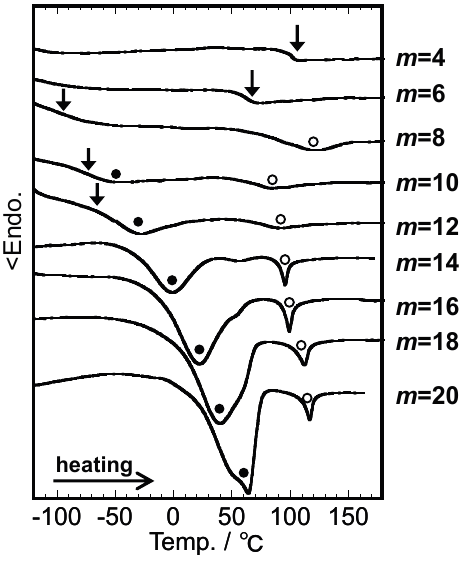
Figure 2. DSC thermograms of cellulose triesters presenting different m values obtained during the second heating scan. Arrows mark T g positions while the filled and open circles represent T m and T i values,